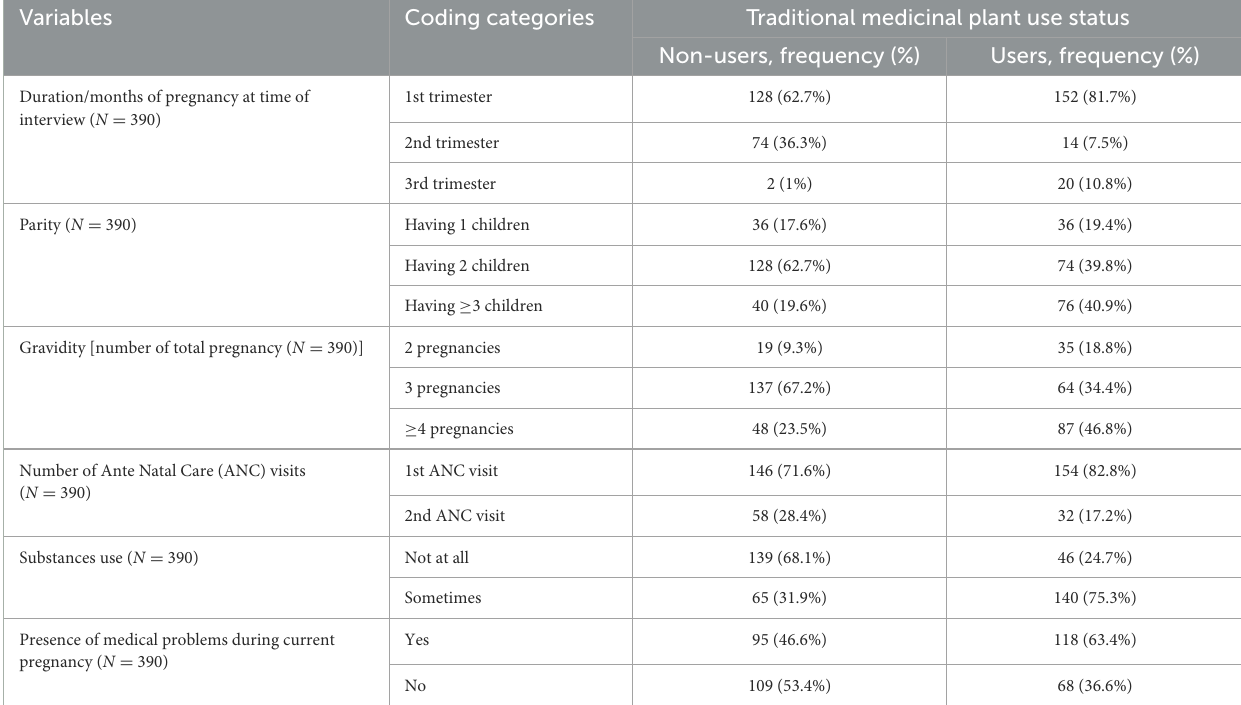
TABLE 2 Revealed pregnancy-related characteristics of the study participants in East Gojjam Zone, Northwest Ethiopia, 2021 ( N = 390). Variables Coding categories Traditional medicinal plant use